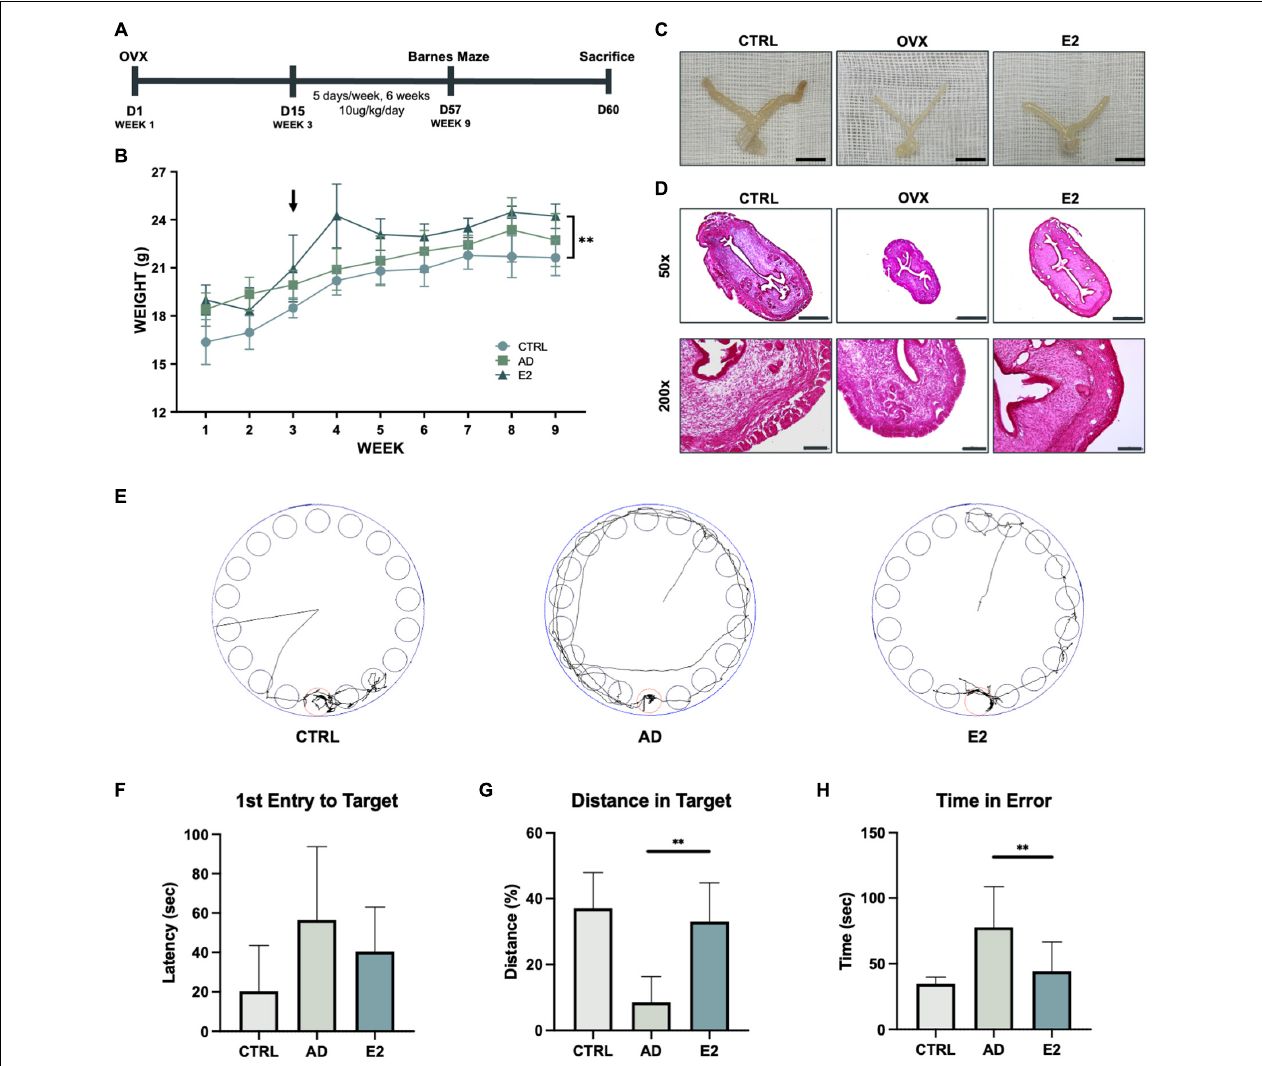
FIGURE 1 | Estrogen treatment of an Alzheimer’s disease model developed using ovariectomized mice improves behavioral performance. (A) Schematic representation of the animal experiment, involving the induction of the postmenopausal state in the Alzheimer’s disease model of mice and treatment with estrogen. (B) Growth curves of control mice and ovariectomized (OVX) mice treated with estrogen. Arrows indicate the time of OVX operation and the starting point of estrogen injection. (C) Uteri of control (C57BL/6), OVX, and OVX + E2 mice. Scale bar, 1 cm. (D) Hematoxylin and eosin staining of mice uterine tissues. Scale bar, 500 µ m for 50 × ; 100 µ m for 200 × . (E) Monitoring of mice from each group for 3 min (180 s). (F) Graph showing the average latency of first entry to target in seconds. (G) Graph showing the average distance traveled in the target relatively. (H) Graph showing the average time spent by the mice outside the target zone in seconds. t -tests were used for data analysis ( ∗∗ P < 0.01). Values are presented as mean ± standard error of the